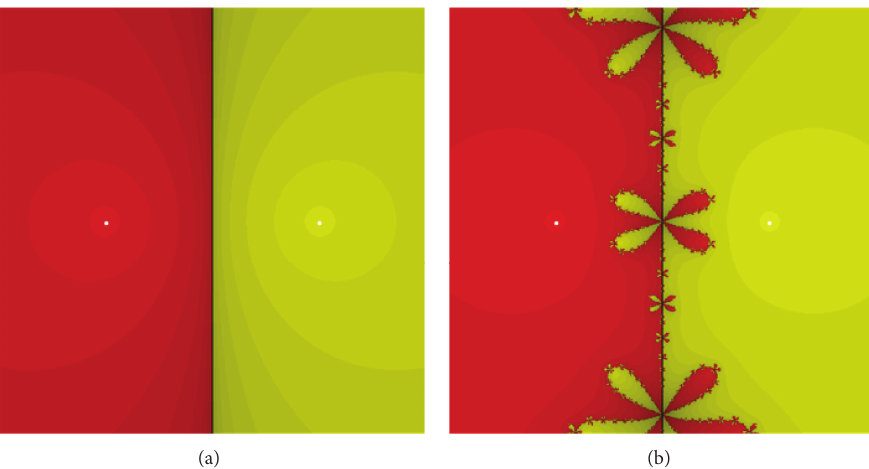
Figure 1: The basins of attraction for (4) (a) and fourth-order method (14) (b) for the polynomial 𝑥 2 − 1 = 0 (shaded by the number of iterations to obtain the